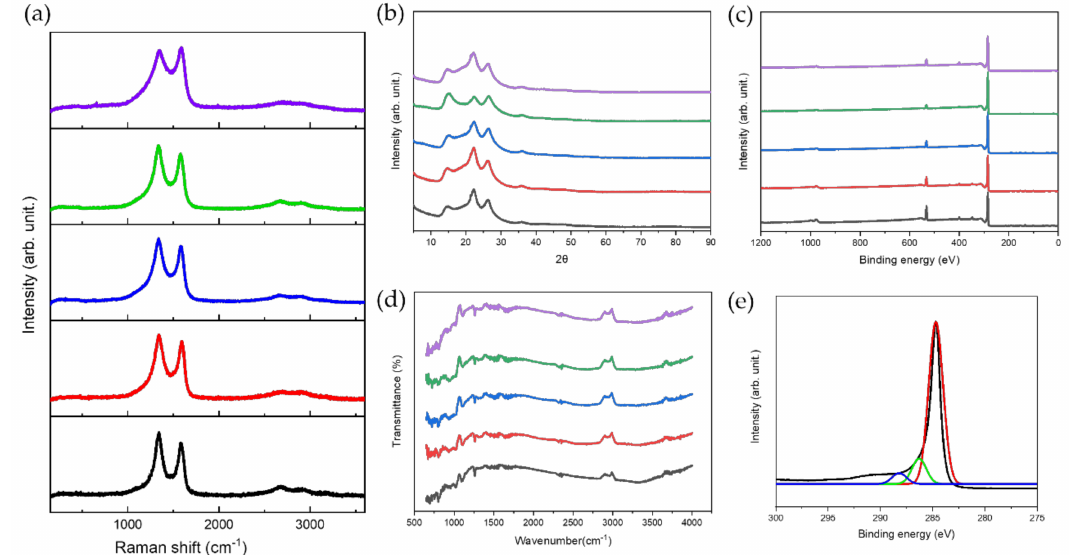
Figure 3. ( a ) Raman spectra of LIG patterns, ( b ) XRD results of LIG patterns, ( c ) XPS characteristics of the LIG patterns according to the laser speed, ( c ) XPS, ( d ) FTIR analysis of LIG patterns, ( e ) XPS C1s data of LIG patterns fabricated at laser speed of 60 mm/s (violet: 100 mm/s, green: 80 mm/s, blue: 60 mm/s, red: 40 mm/s black: 20